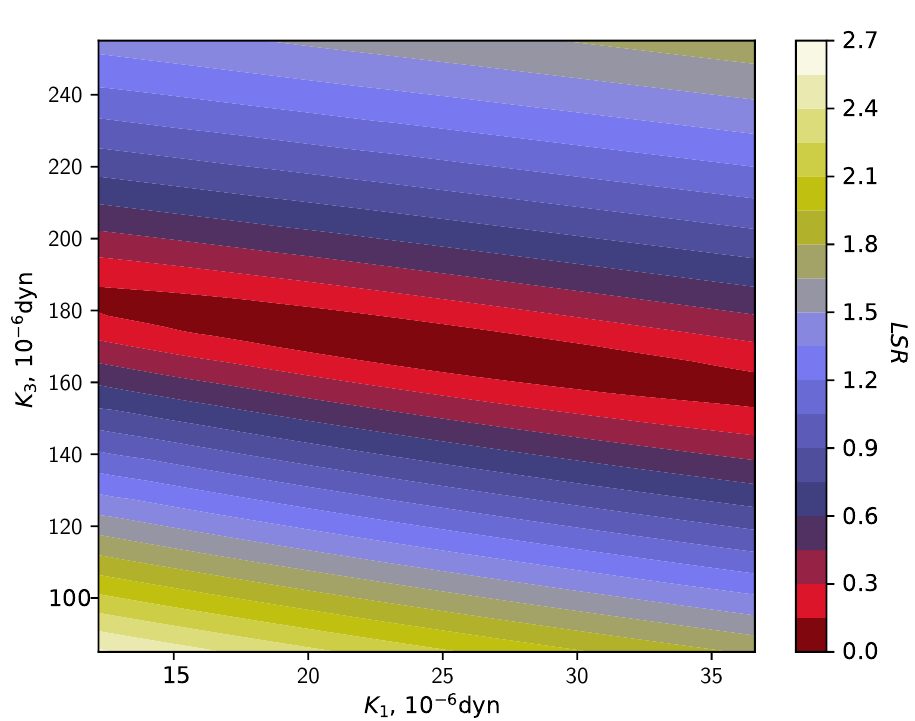
Figure 7. The map for the least squares root (LSR) criterion on K 1 , K 3 for the test dependence based on Gd